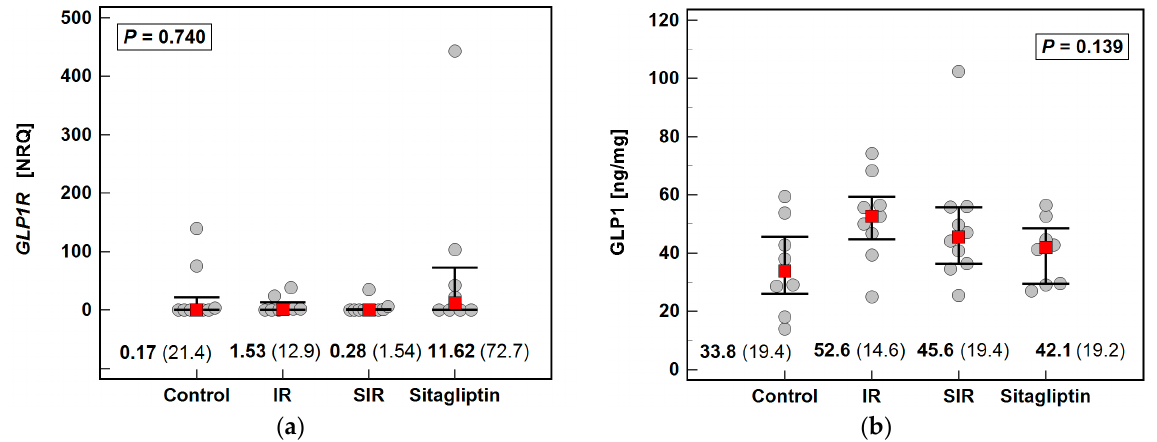
Figure 4. Effect of IR injury and sitagliptin on GLP1R/GLP1 axis in the liver: ( a ) Glp1r expression; ( b ) GLP1 concentration. Data were analyzed using the Kruskal–Wallis H test and are presented as medians with IQR (red squares with whiskers and numbers below dot-plots). NRQ, normalized relative quantity; IR, ischemia-reperfusion; SIR, sitagliptin pretreatment and ischemia-reperfusion; IQR, interquartile range.